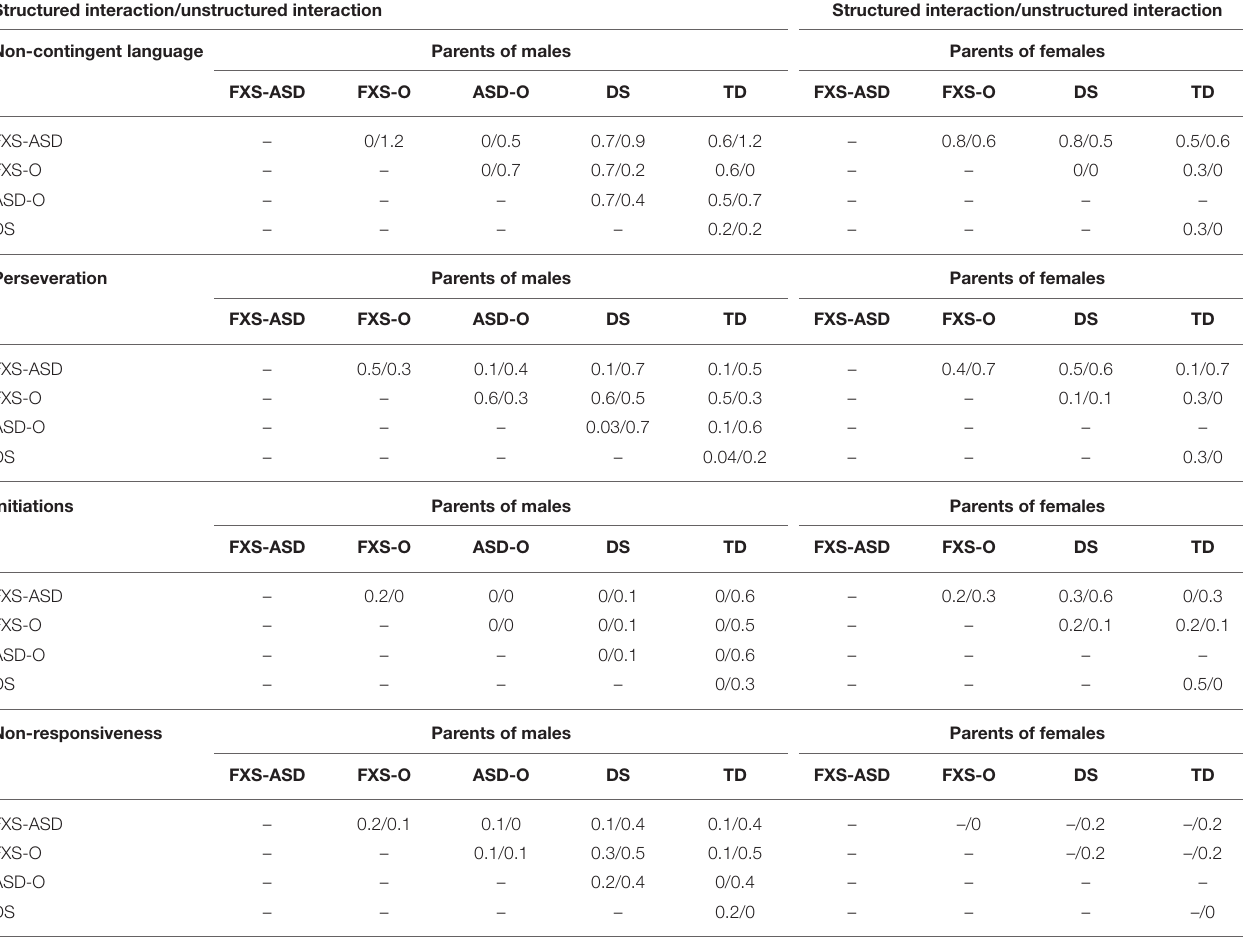
TABLE 4.3 | Effect sizes (Cohen’s d) for pragmatic language in